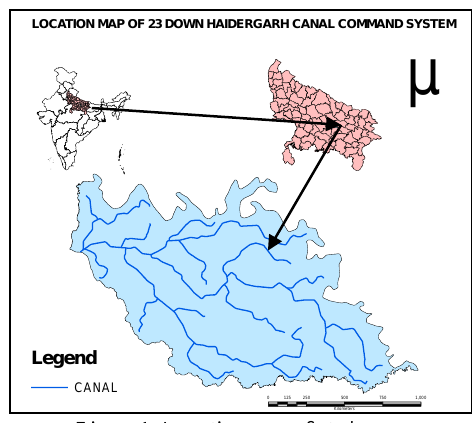
Figure 1: Location map of study